Question: Which kind of chart has been used to present this data?
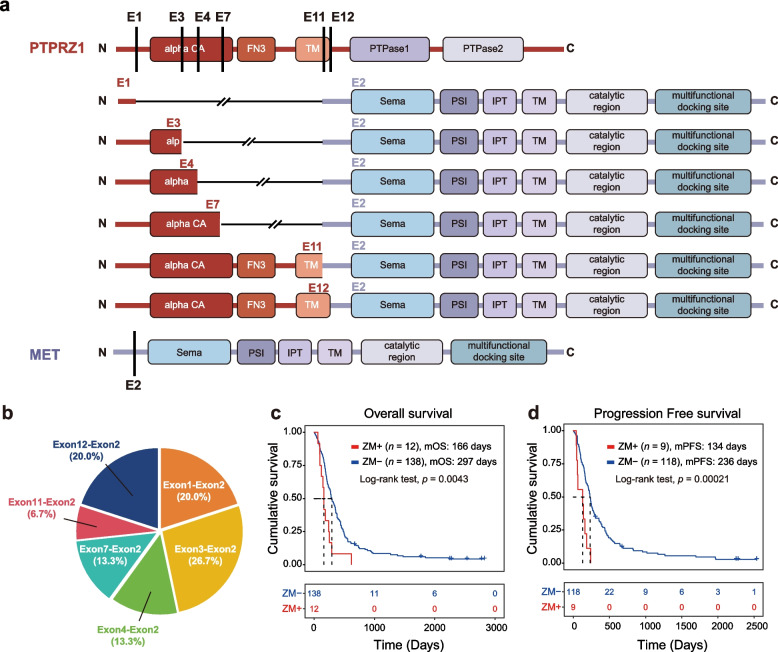
Answer: survival